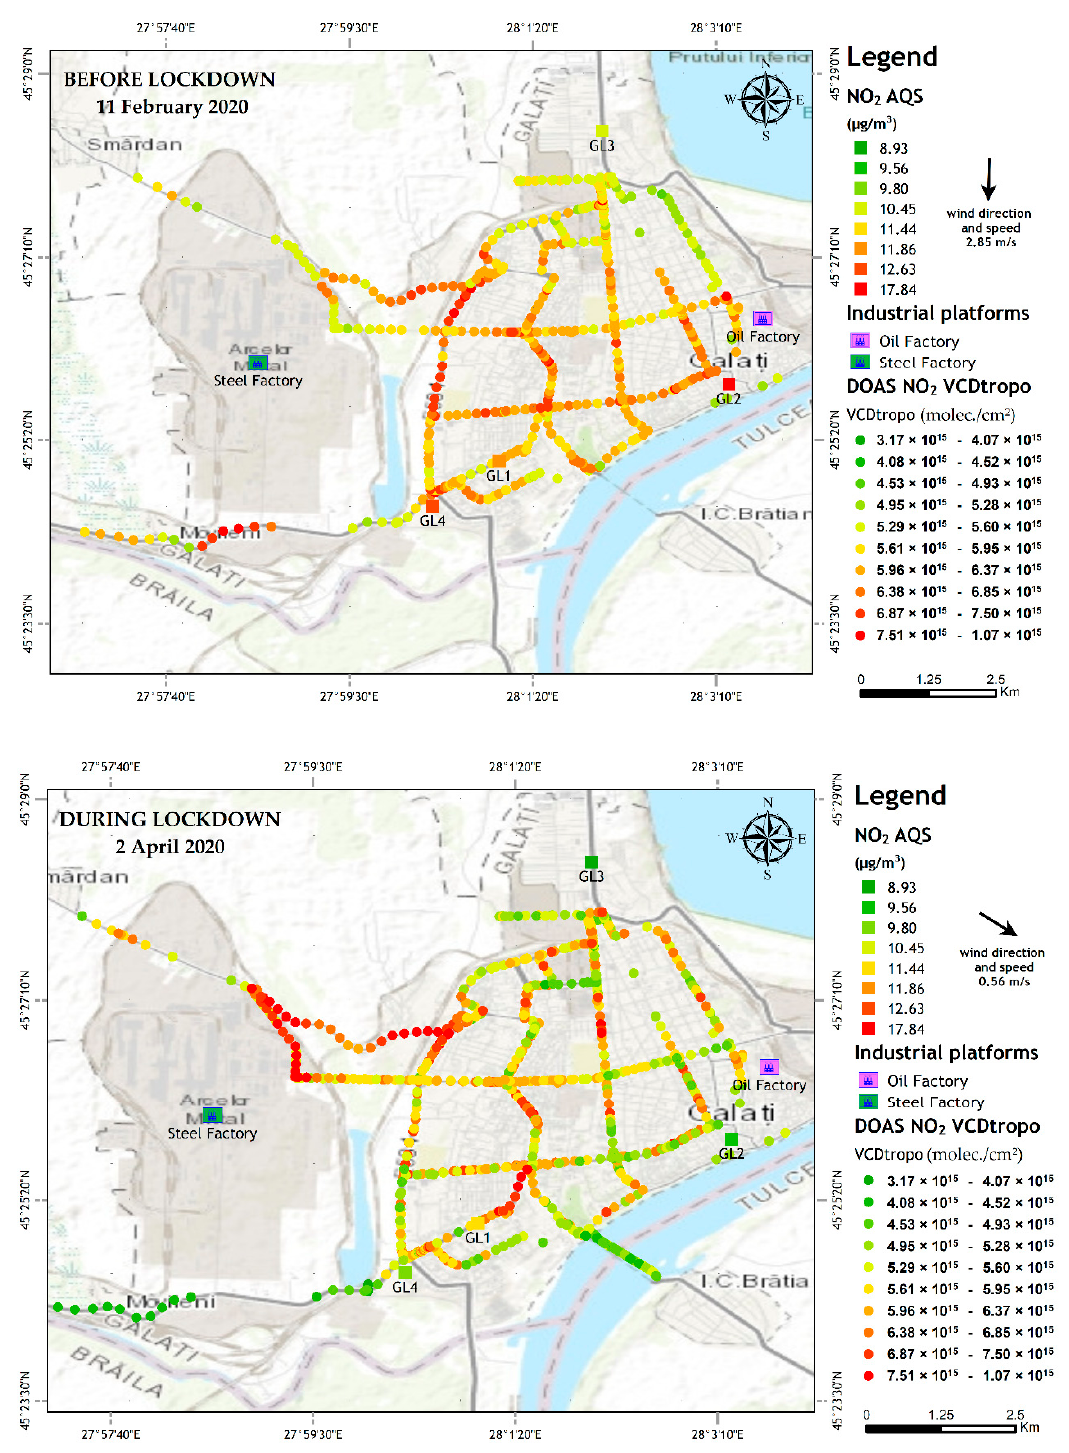
Figure 8. Distribution of NO 2 VCD tropo measured by the mobile DOAS (colored dots) along the main streets and in situ NO 2 local concentration (colored squares) at the four stations in Galati on 11 February 2020 (upper map) and 2 April 2020 (lower map). The color of the squares represents the average in situ NO 2 concentration at the time when the UGAL mobile DOAS system drove by the station.